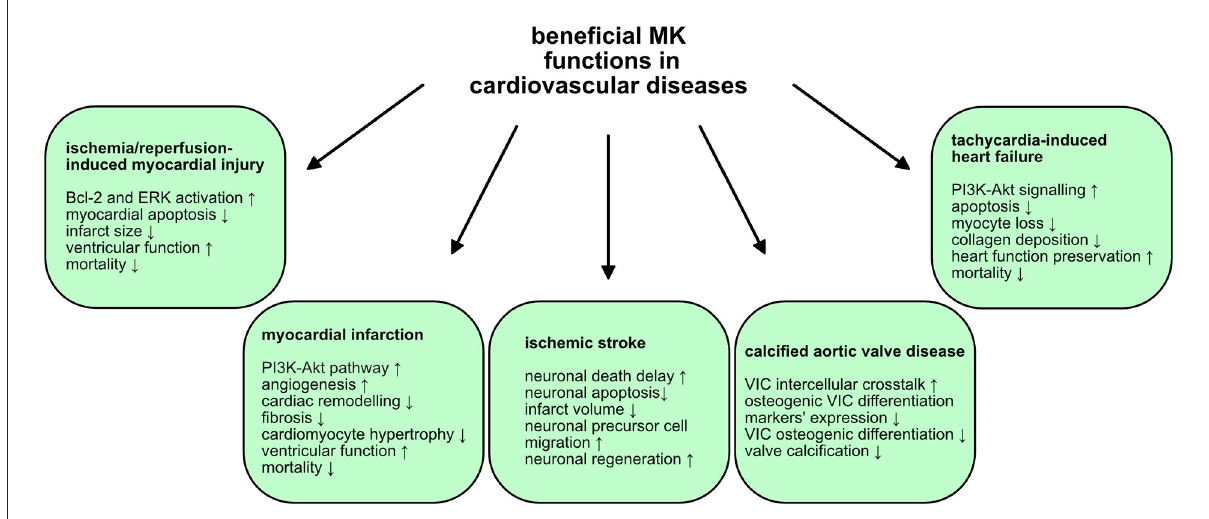
FIGURE2 Beneficial MK functions in cardiovascular diseases. MK exercises advantageous and protective functions in some cardiovascular diseases. The mechanisms and signaling pathways utilized by MK are illustrated.